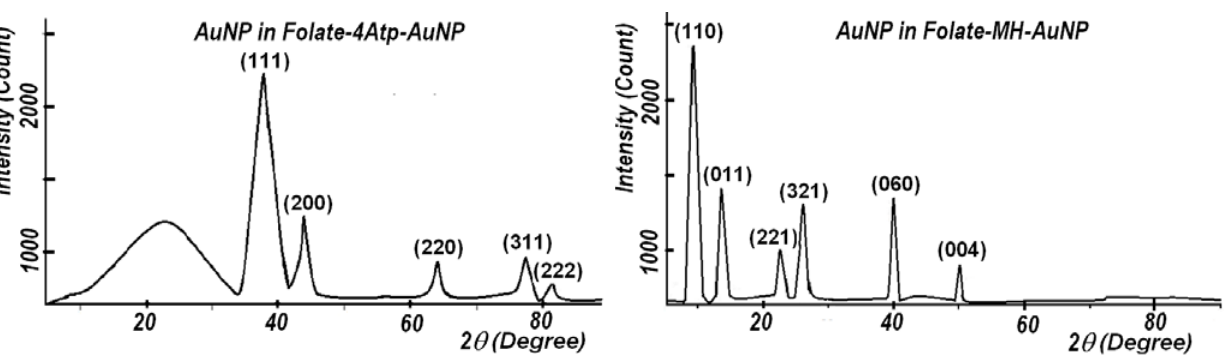
Figure 8. X-ray diffraction (XRD) patterns of Au nanoparticles